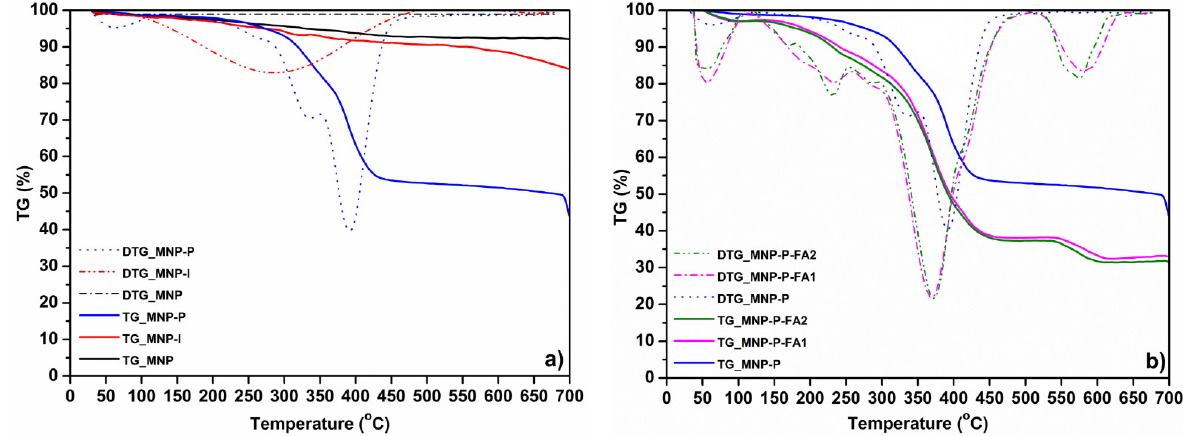
Figure 4. Thermal gravimetric/derivative thermal gravimetry (TGA/DTG) curves of: ( a ) MNP (black), MNP-I (red), MNP-P (blue), and ( b ) MNP-P (blue), MNP-P-FA1 (magenta), and MNP-P-FA2 (green).